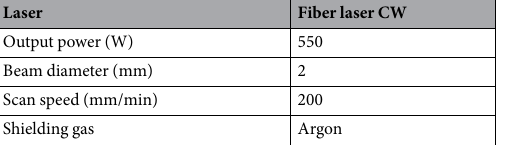
Table 3. The operating parameters in printing SS316 on Ti6Al4V by laser.